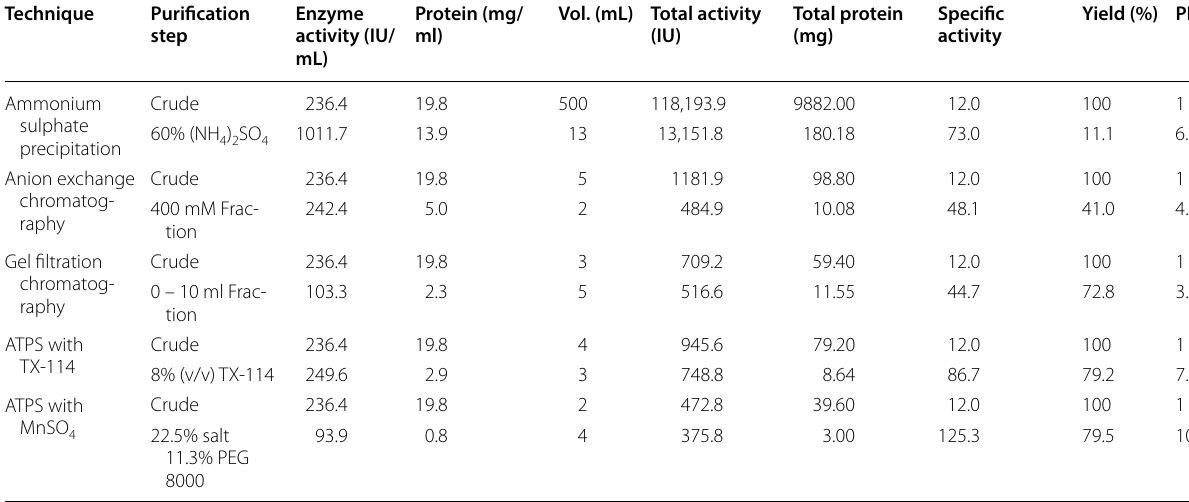
Table 4 Comparative analysis of different purification strategies for the cellulase from Schizophyllum commune NAIMCC-F-03379